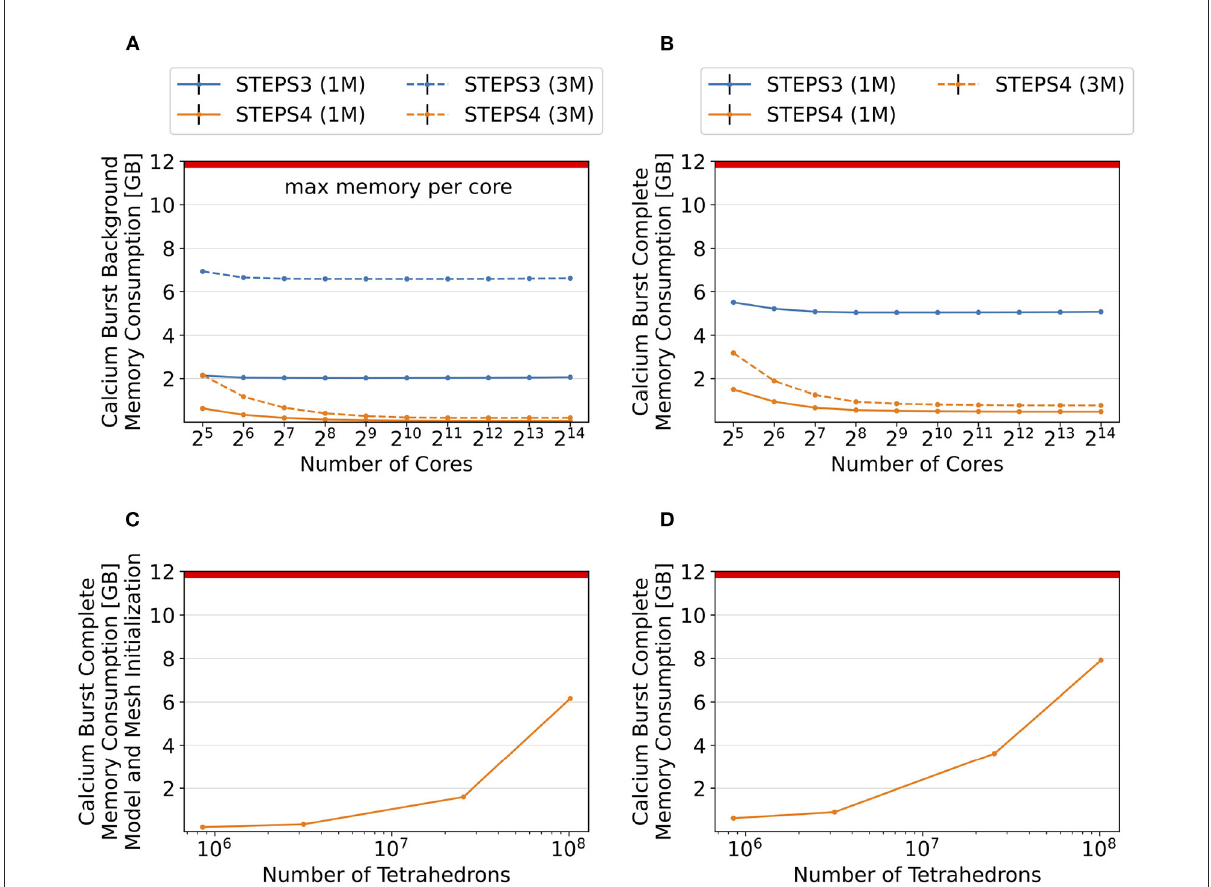
FIGURE11 Memory footprint analysis and exploration of super-large scale models. In general, per-core memory consumption decreases as the core count increases, until a stabilized minimum consumption is reached. (A) Results of the background model simulations. The memory required per core hardly changes for STEPS 3 from 2.1GB to 2.0GB, while it declines rapidly for STEPS 4 from 626MB to 67MB. Similar results can be observed in the 3M series, where per-core memory consumption declines from 6.9GB to 6.6GB for STEPS 3, and from 2.1GB to 200MB for STEPS 4. (B) Results of the complete model simulations. In the 1M series results, memory consumption decreases from 5.5GB to 5.1GB for STEPS 3, and from 1.5GB to 500MB for STEPS 4. STEPS 4 in the 3M series consumes 3.2GB to 770MB of memory per core as core count increases. The 12GB memory capacity of the cluster per core is inadequate for the 3M complete model simulations with STEPS 3. (C) Memory consumption in GB at the initialization stage for the 1, 3, 25, and 100M meshes. (D) Total memory consumption in GB of STEPS 4 for the 1, 3, 25, and 100M mesh models. From our estimation, the 200M mesh requires a little over the 12GB memory capacity per core in the current setup using 16,384 MPI